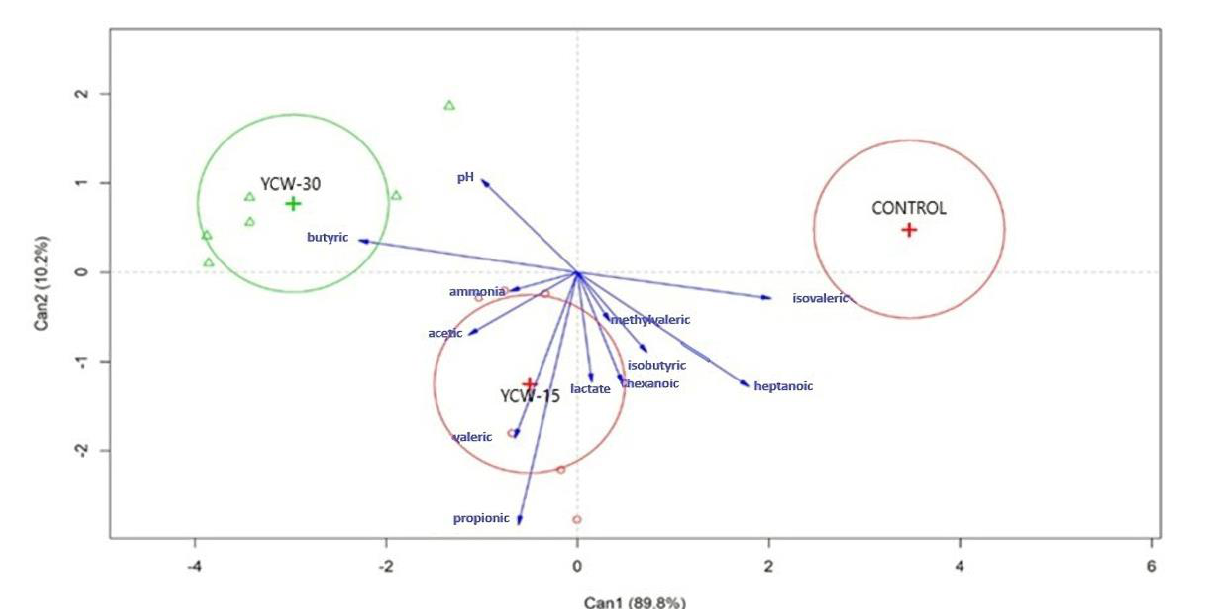
Figure 1. Biplot of canonical component analysis using the first and second components (PC1, 89.8%; PC2, 10.2%). Treatments are located according to their coordinates in the components. Vectors are related to the trend of the variables in the treatments.